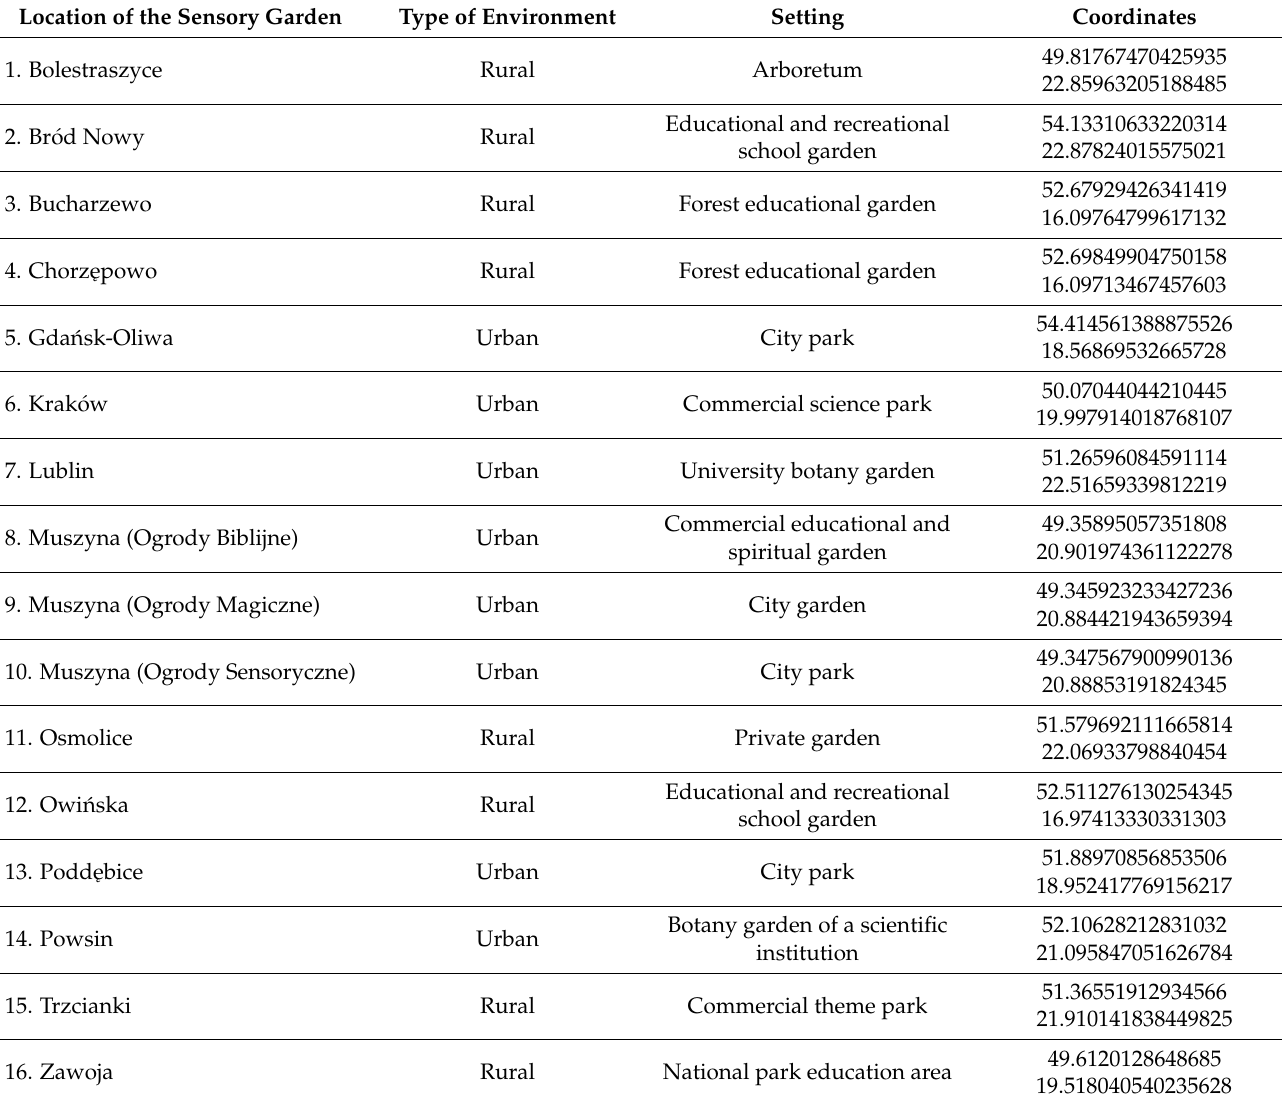
Table 1. Details of the location and type of sensory gardens included in the